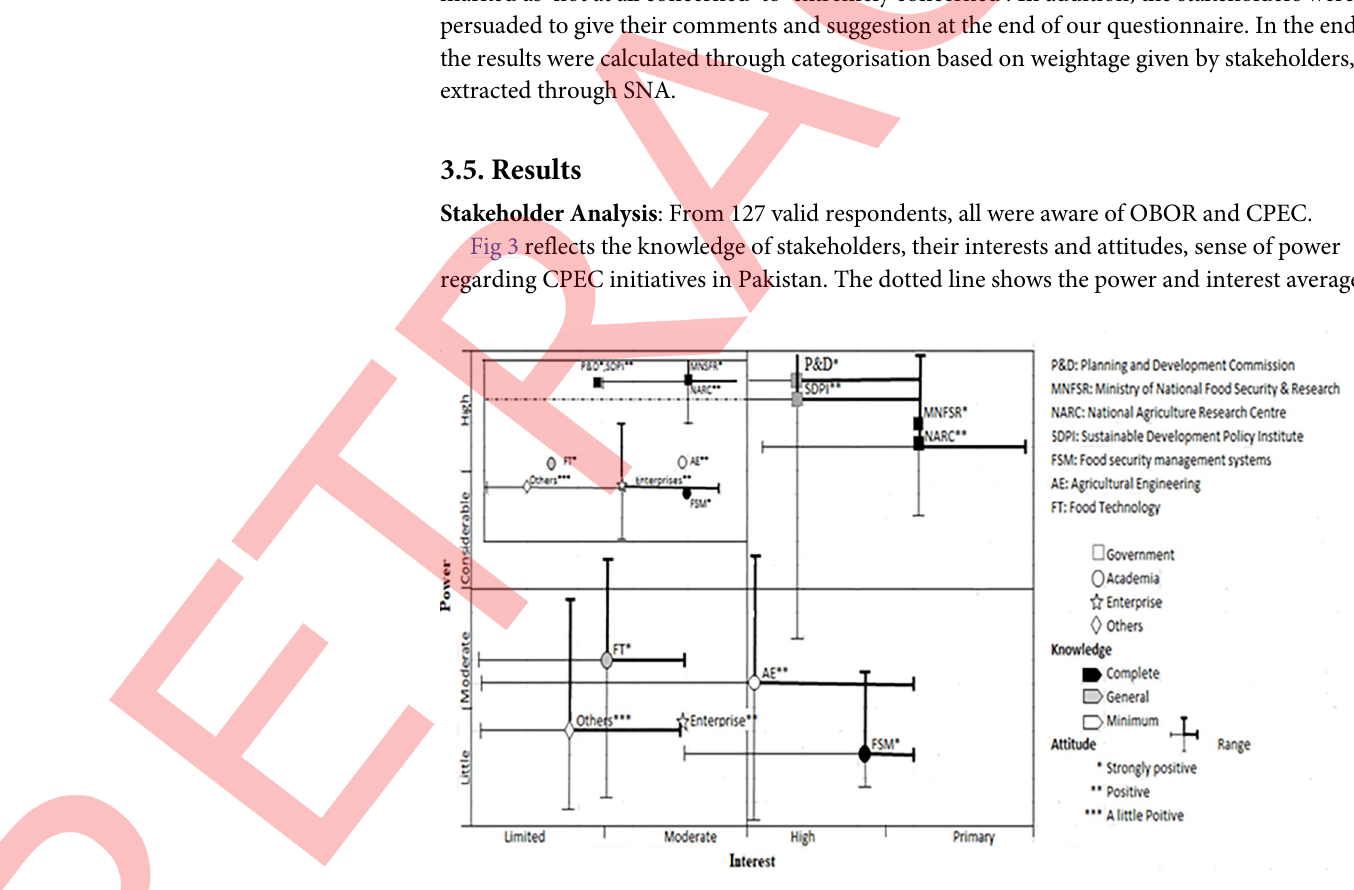
Fig 3. Power versus interest grid, with knowledge and attitude about CPEC in Pakistan as an attribute for